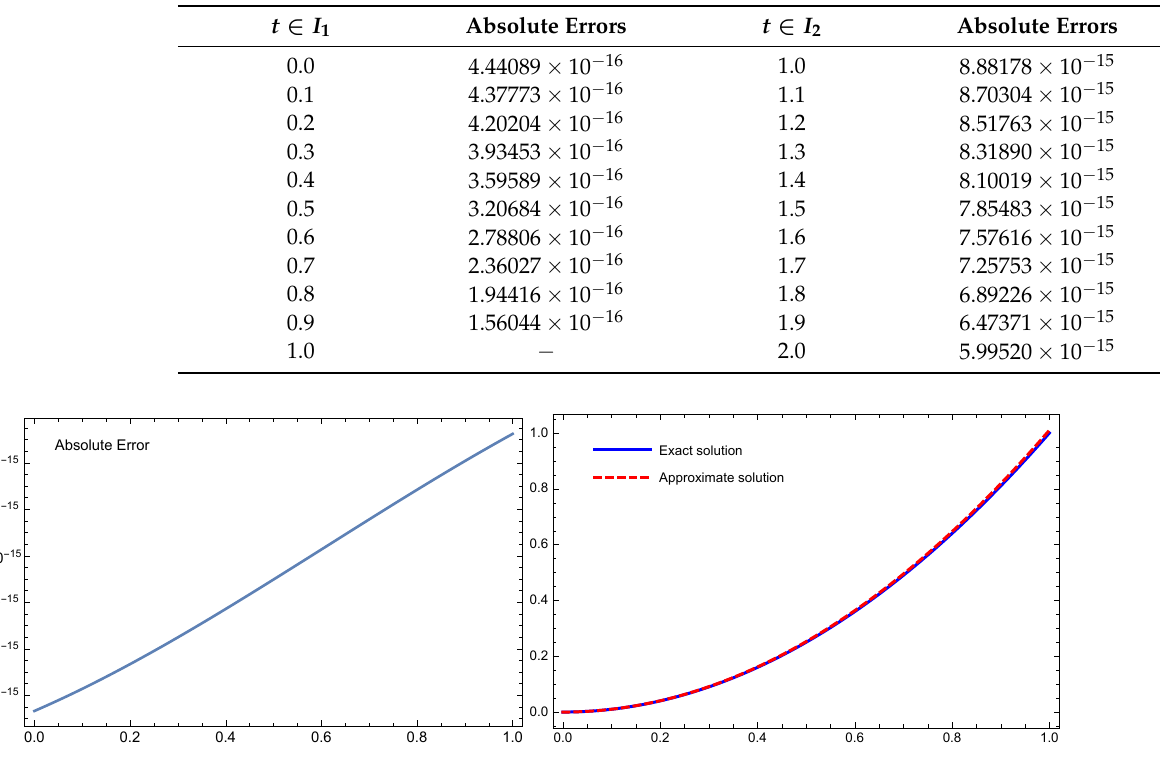
Table 3. Absolute error comparisons for the presented method for Example 2, ξ = 1.5, m = 3. t ∈ I 1